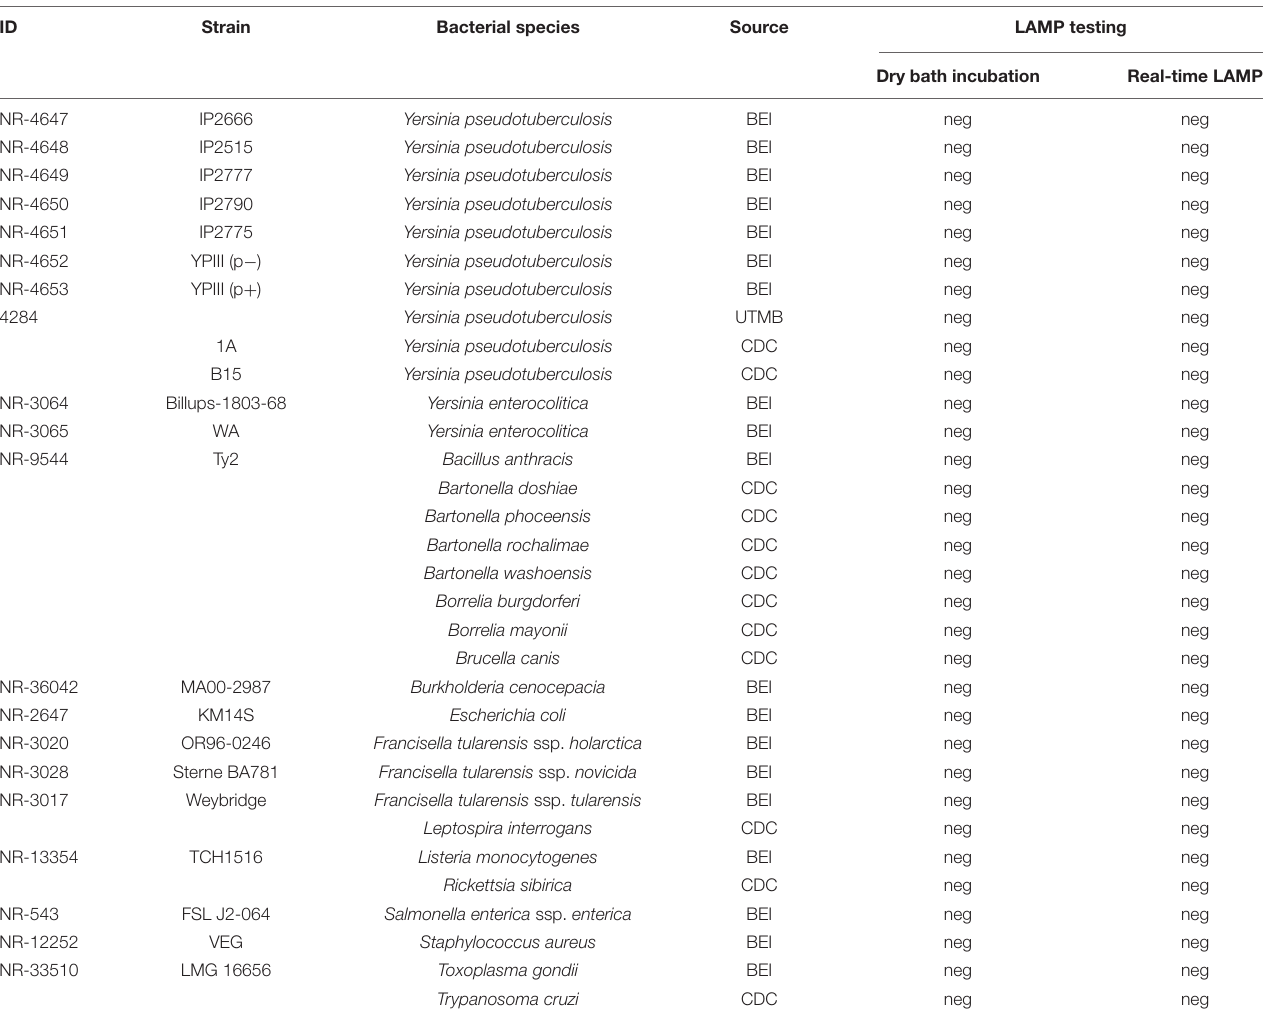
TABLE 3 | Specificity testing of the LAMP